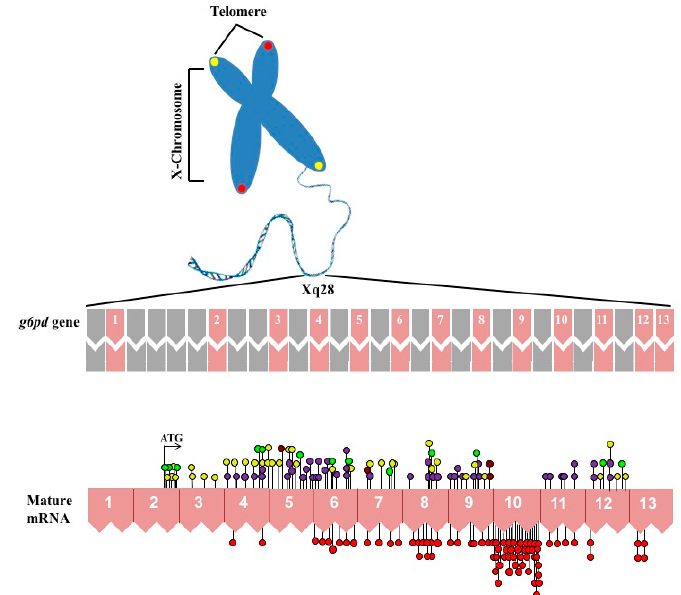
Figure 1. Schematic overview of X chromosome and distribution of mutations in g6pd gene coding sequence. The top shown the introns and exons that are shown in gray and pink color boxes, respectively. The numbers (1–13) indicate exons of the human g6pd gene. In the bottom , the mRNA is schematized and all the single nucleotide substitutions (missense variants) are showed. The red circles are mutations associated with chronic nonspherocytic hemolytic anemia. Purple circles showed the Class II mutations. Class III mutations are shown in yellow circles. Class IV mutations are shown in brown circles and the unnamed reported class mutations are shown in bright green circles.